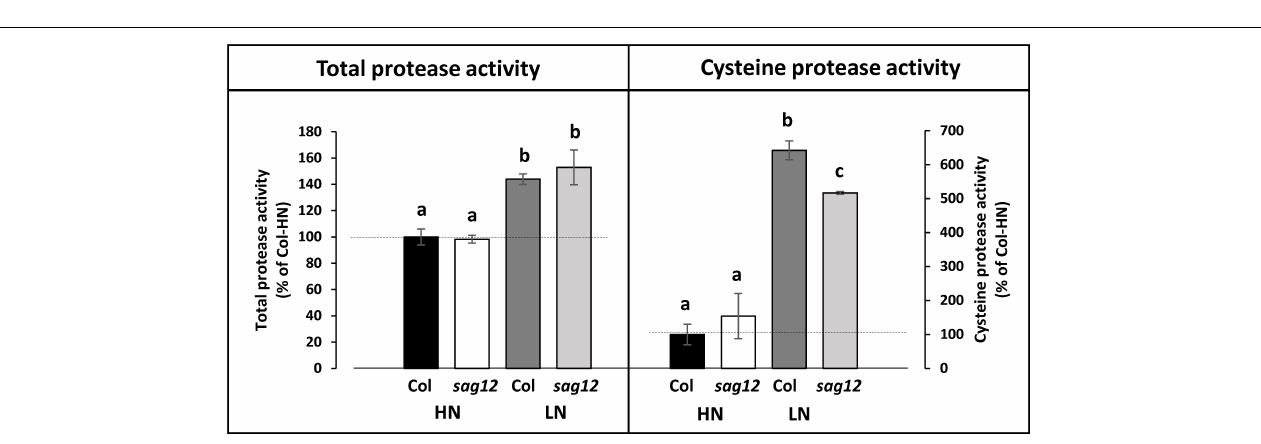
FIGURE 7 | Cysteine protease activity is decreased in roots of sag12 under LN conditions. Soluble proteins were extracted from roots harvested at the reproductive stage (85 DAS) from Col and sag12 plants cultivated under high (HN) or low (LN) nitrogen conditions. The cysteine and total protease activities were determined by monitoring the degradation of four endogenous proteins (95, 76, 50, 37 kDa) in the presence or the absence of the cysteine protease inhibitor E64. The protease activities are expressed as a percentage relative to the activity in the Col roots under HN conditions (100%; dot line). Values are means ± SE, n = 3. For a given protease activity (total or cysteine), significant differences ( p ≤ 0.05, n = 3) are indicated by different lower case